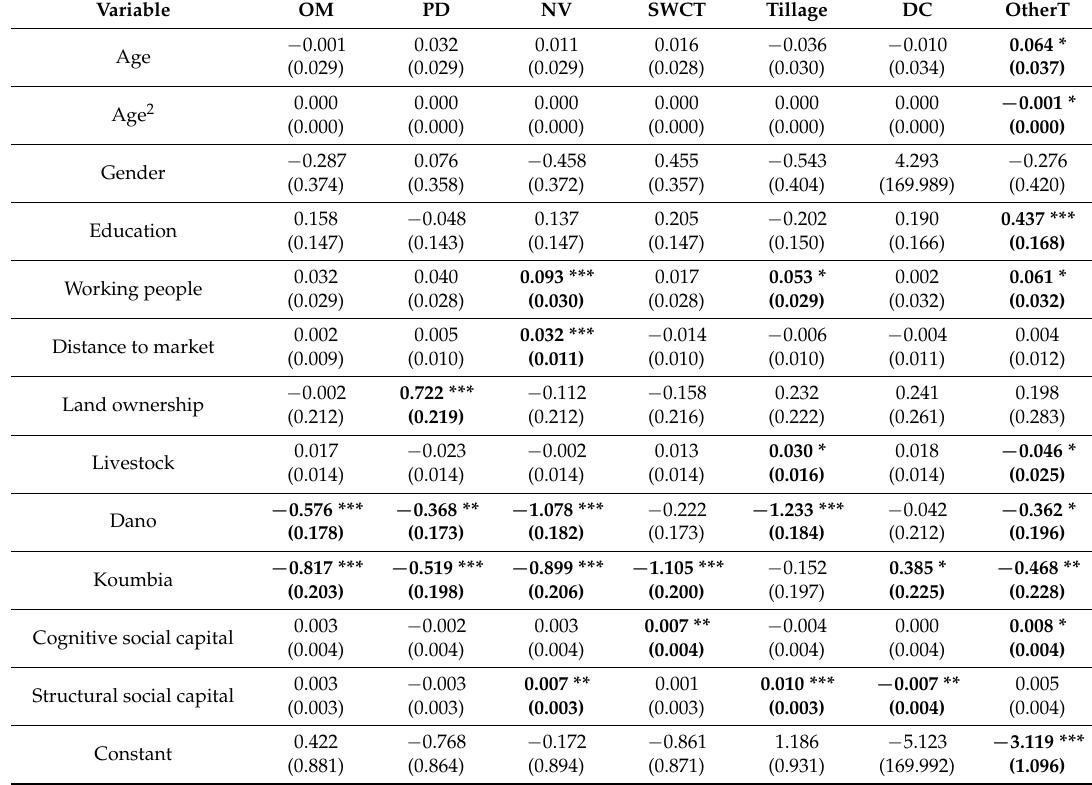
Table 5. Multivariate probit model